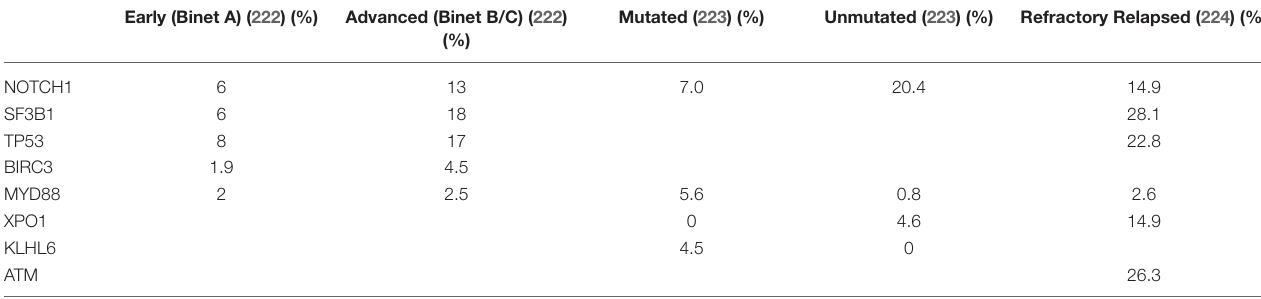
TABLE 1 | Recurrently Mutated Genes in Different Clinical Settings. Early (Binet A) (222)